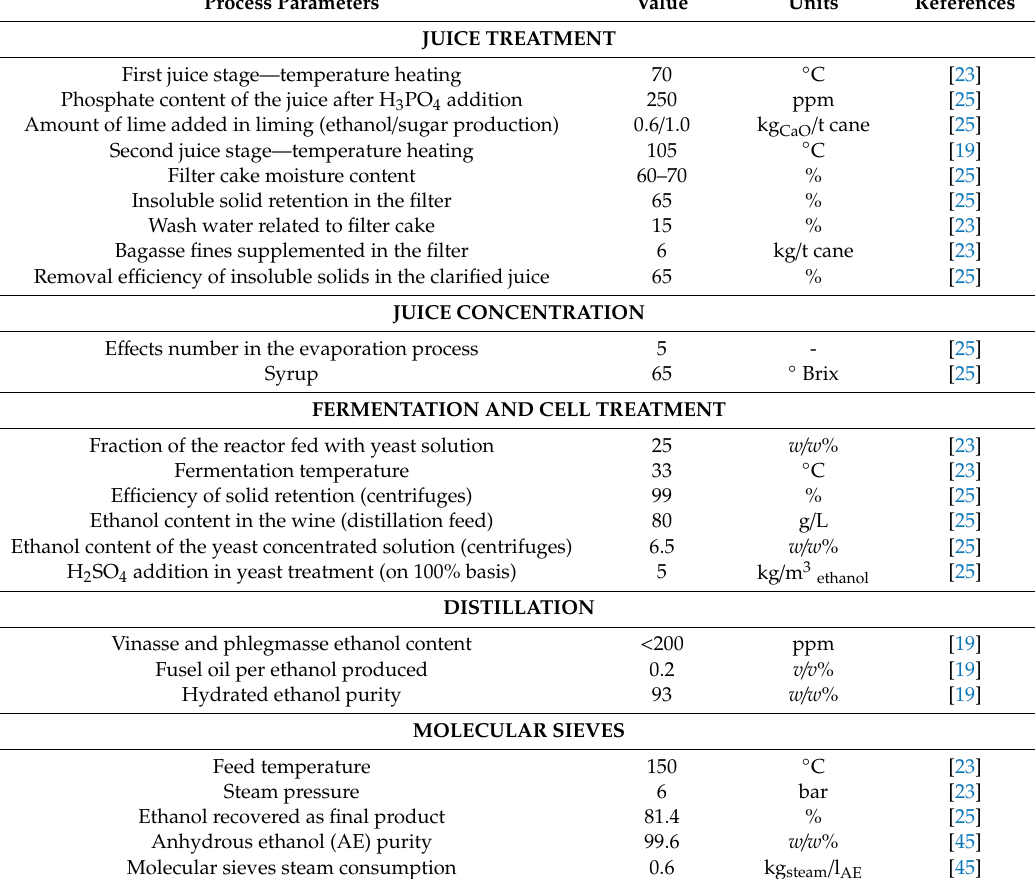
Table A4. Main technical parameters used in the traditional ethanol production (1G) plant